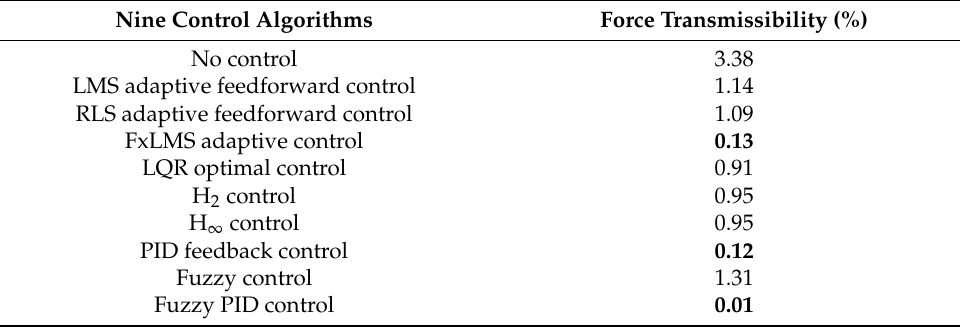
Table 4. Force transmissibility of each control algorithms at 3000 rpm .